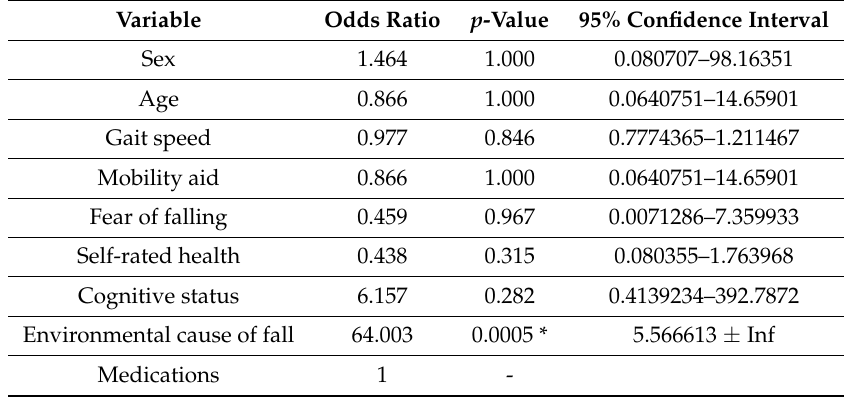
Table 5. Results of bivariate analysis: falls as dependent variable. n = 16; * statistical significance set at α =